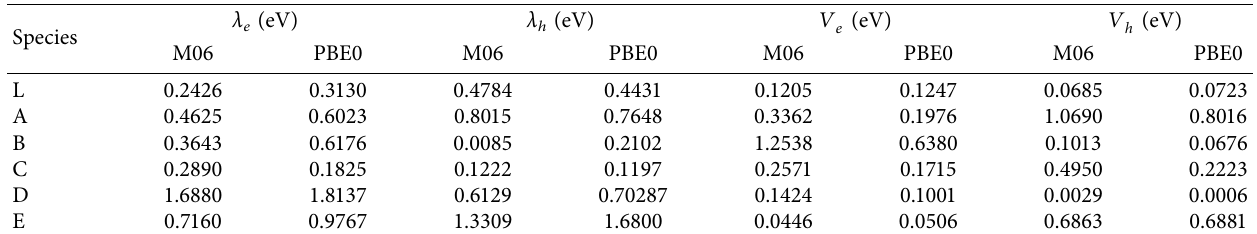
Table 6: Computed values of reorganization energies ( λ def2-TZVP level of theories in gas